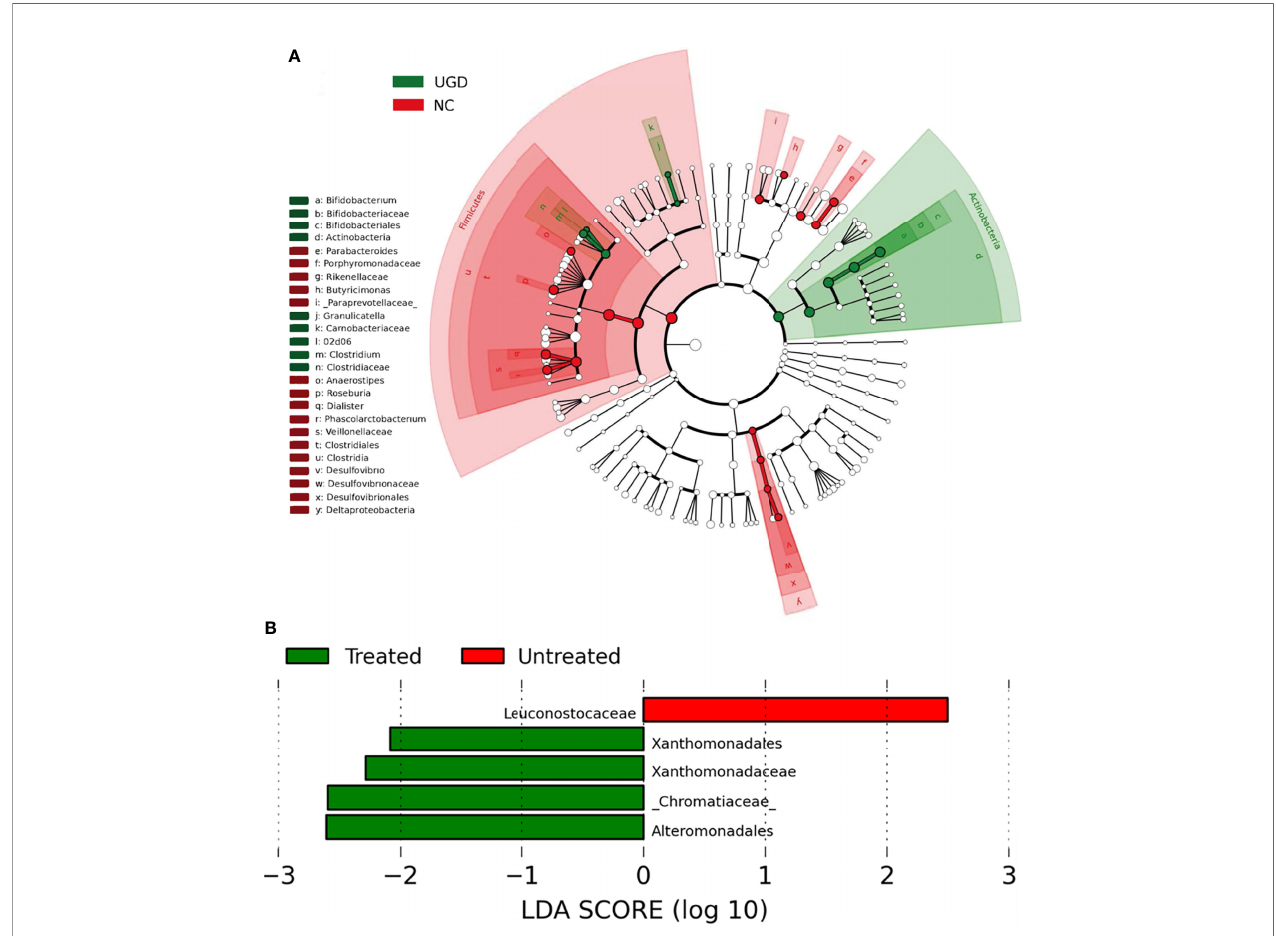
TABLE 3 | Statistical table for the comparison of the Metastats test results among the 3 groups. Sample